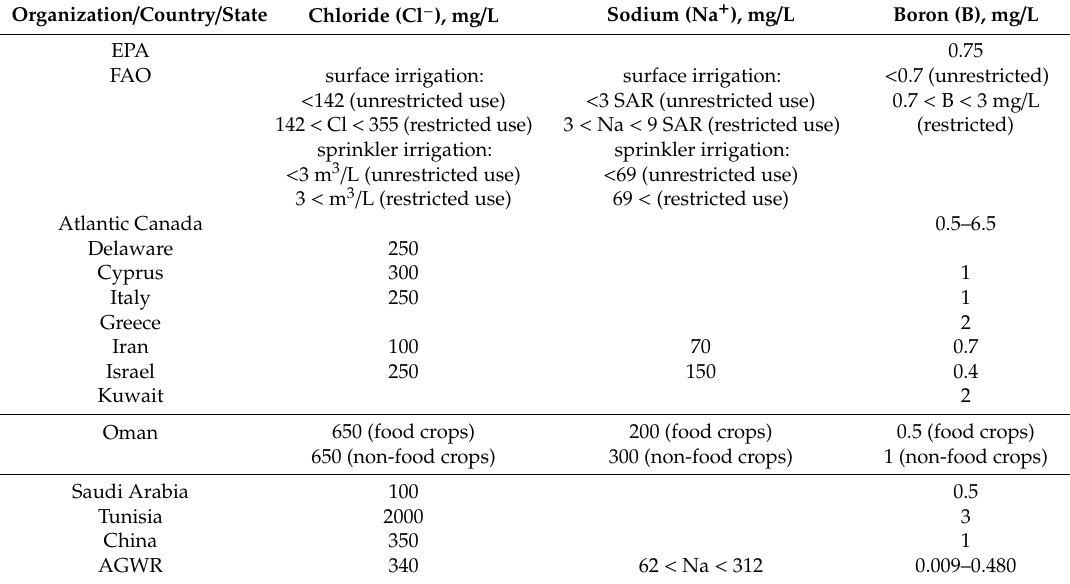
Table 11. Toxic ions (Chloride, Sodium, and Boron) thresholds in agricultural water reuse regulations and